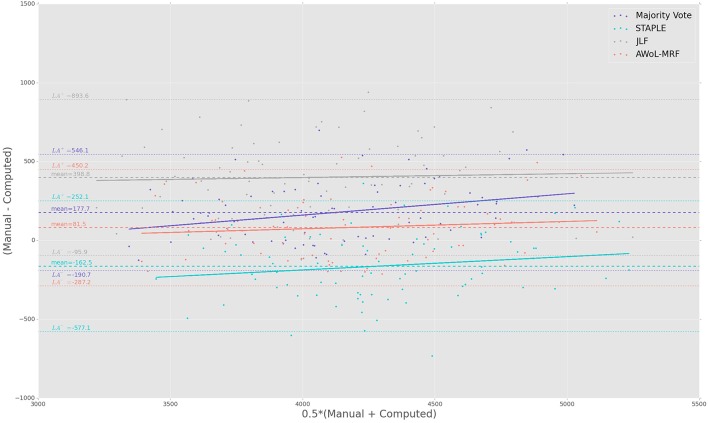
Experiment II Bland-Altman Analysis: Comparison between computed and manual volumes (in mm3) for single parameter configuration of 9 atlases and 19 templates. The overall mean difference in volume, and limits of agreement (LA+/LA−: 1.96SD) are shown by dashed horizontal lines. Linear fit lines are shown for each method. Note that the points above the mean difference indicate underestimation of the volume with respect to the manual volume, and vice versa.